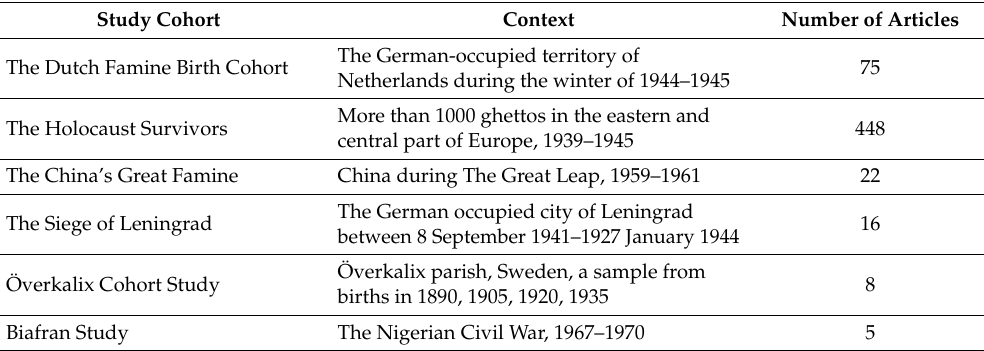
Table 1. The selected cohorts and the number of articles for each cohort.